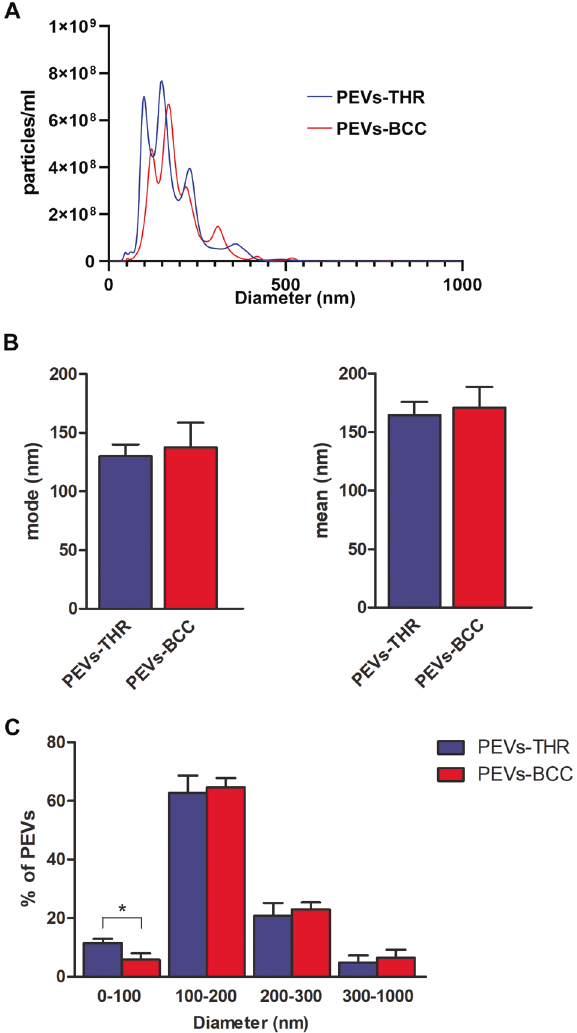
Fig. 2 Analysis of size distribution of PEVs. A Representative size distribution of PEVs-THR and PEVs-BCC obtained by NanoSight analysis. B Quanti fi cation of the analysis of PEVs size expressed as mode (i) and mean (ii) diameter. Results are reported as the mean ± SD of three independent experiments. C Size distribution expressed as the percentages of particles detected in the different dimension ranges (0 – 100, 100 – 200, 200 – 300, 300 – 1000 nm). The results are reported as the mean ± SD of three experiments. Statistical signi fi cance of the differences was calculated between PEVs-THR and PEVs-BCC within the same size range. * p < 0.05.